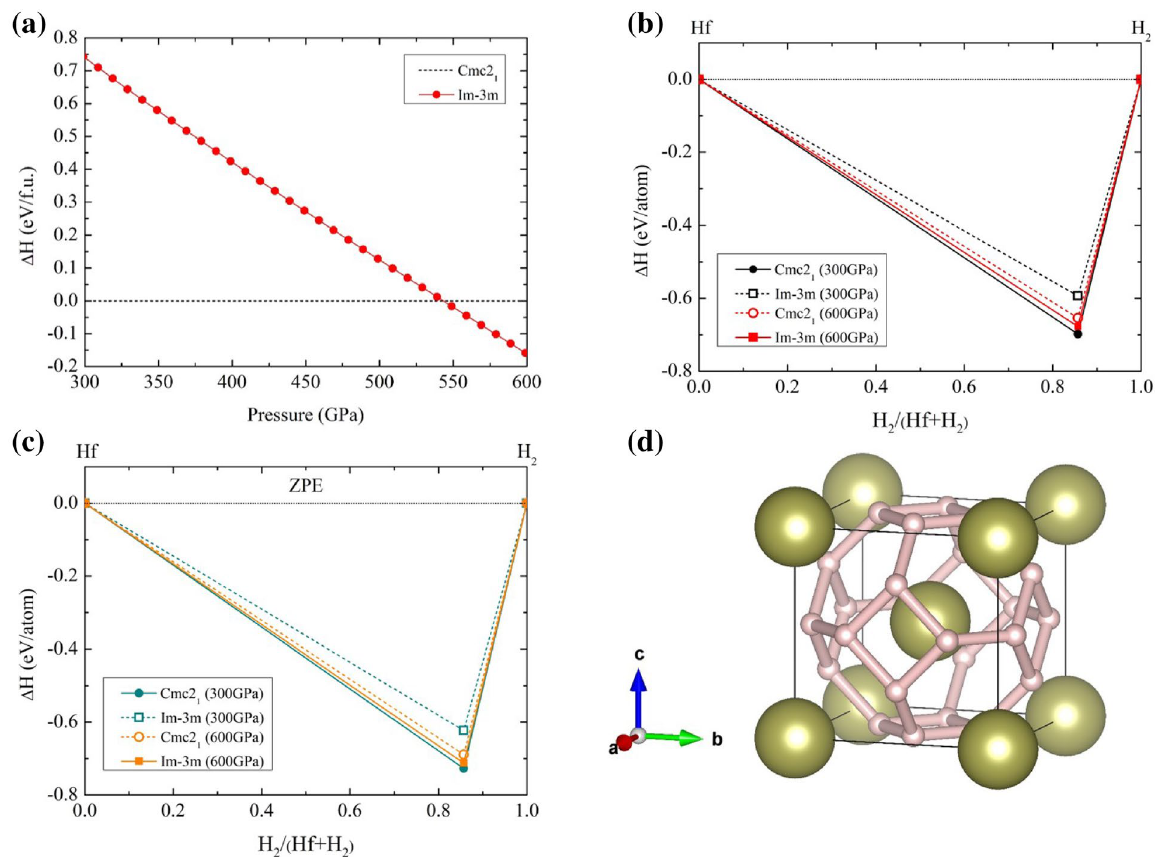
Figure 1. ( a ) The relative enthalpy of HfH 6 ranging from 300 to 600 GPa ( b ) Formation enthalpies of predicted HfH 6 , excluding ZPE with respect to decomposition into Hf and H under pressure. ( c ) Formation enthalpies of predicted HfH 6 , including ZPE with respect to decomposition into Hf and H under pressure. ( d ) The body- centred cubic structure of HfH 6 , where the gold spheres represent the Hf atoms ans the pink sphere represents the H atoms, respectively.(drawn by VESTA (ver. 3.4.7) 51 (URL https:// jp- miner als. org/ vesta/ en/ downl oad.